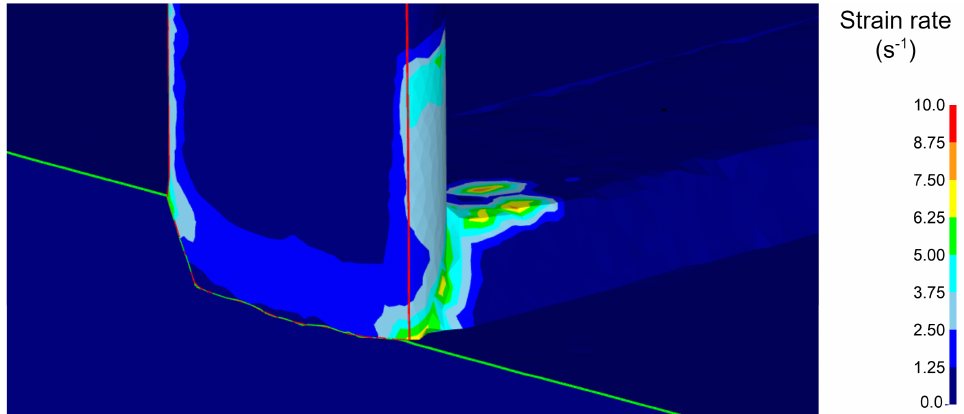
Figure 14. Strain rate at the bonding interface. The strain rates are in the range of 0 to 7 s − 1 .